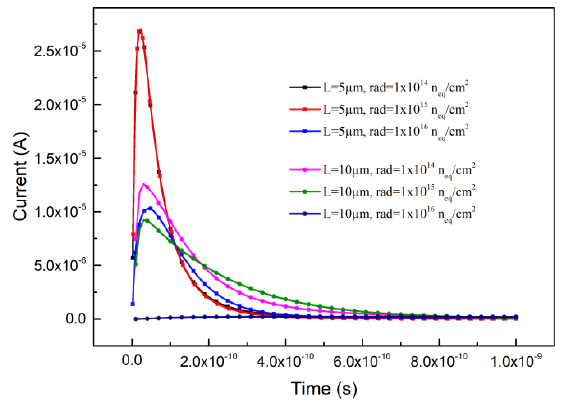
Figure 4. The induced current curves with transient time.